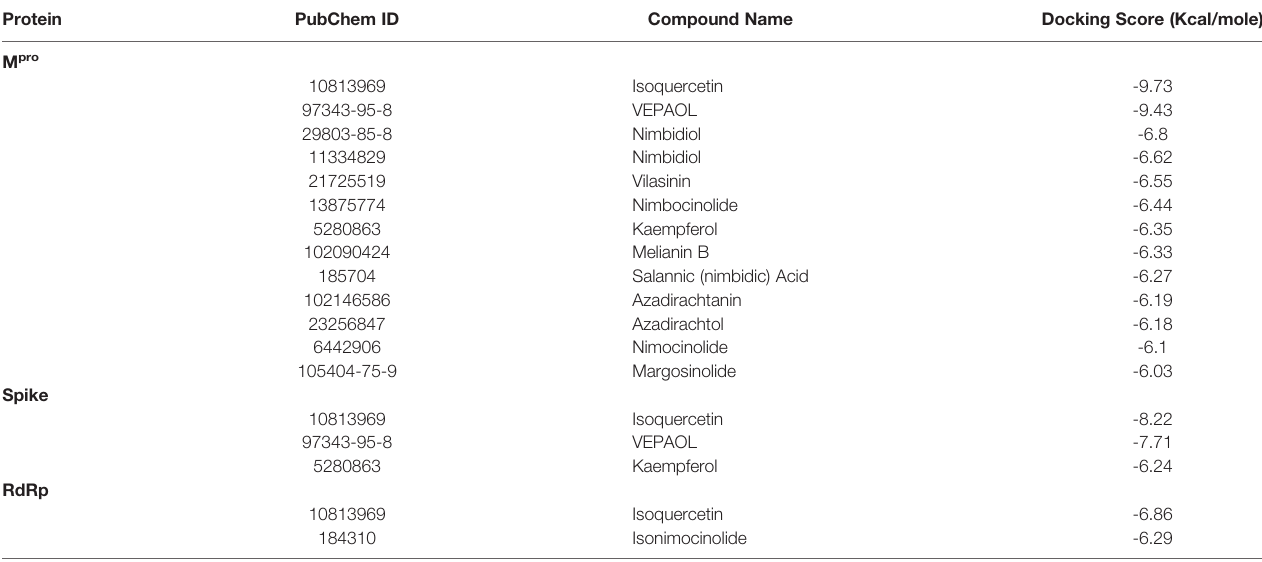
Docking Score with cutoff < − 6.0 kcal/mole is